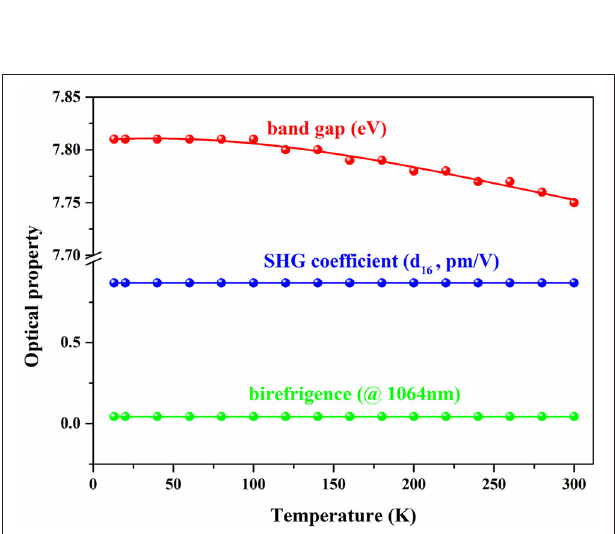
FIGURE 5 | Function of the calculated band gap, SHG coefficient and birefringence (@1,064nm) of BABF with respect to temperature.